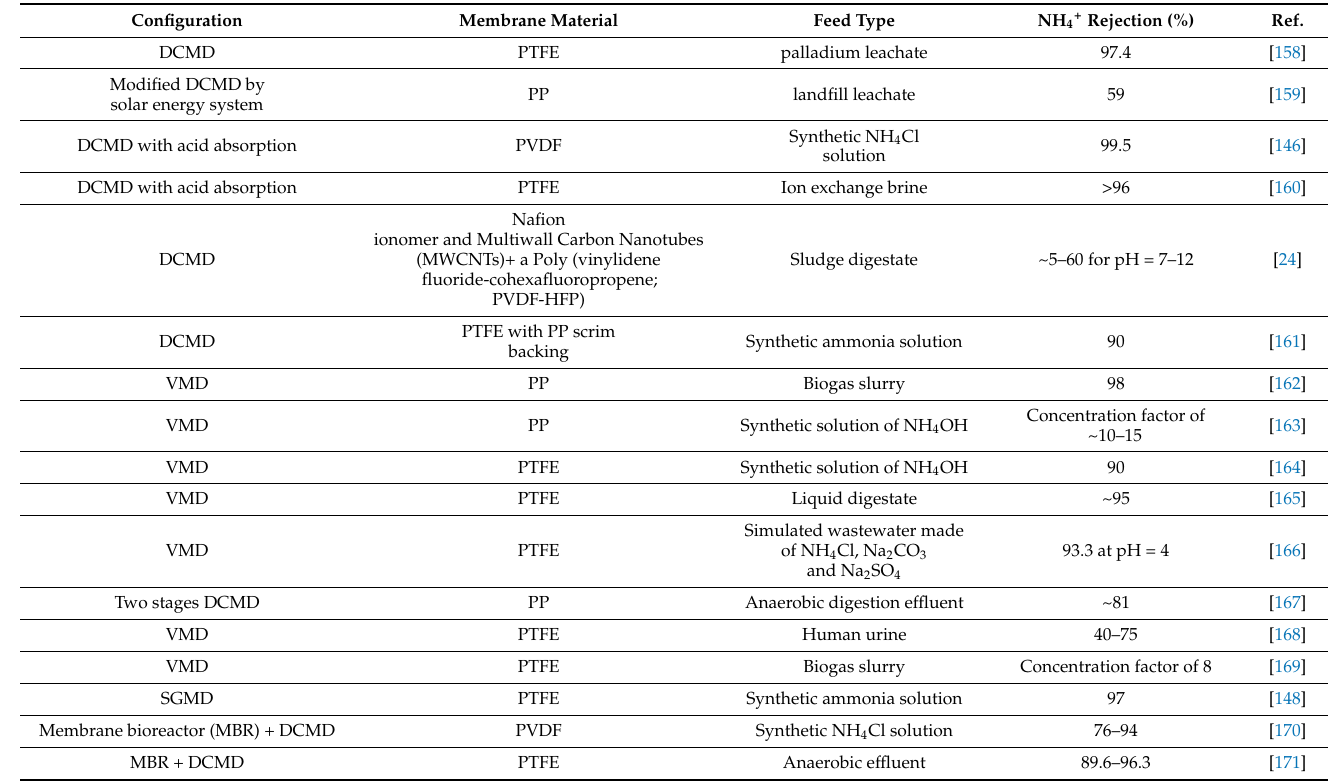
Table 4. Nitrogen recovery with MD